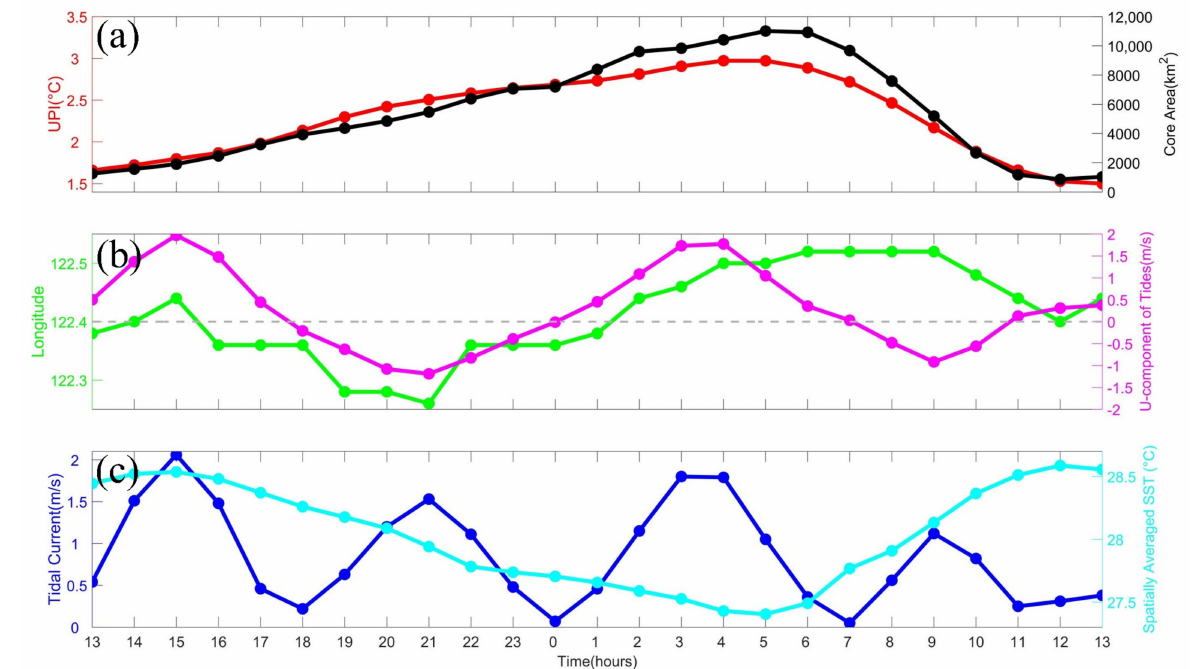
Figure 10. The UPI and core area ( a ), longitude of upwelling center and U − component of tidal current ( b ), tidal current and area − mean SST over the center − searching box ( c ) between 13:00 18 August and 13:00 19 August 2020 (Beijing time, UTC + 8). The gray dashed line in panel ( b ) shows the zero-speed line. The tidal data were downloaded from the Zhoushan Sea Tide Informa- tion Release System (http://hai.edianweb.cn) accessed on 12 April